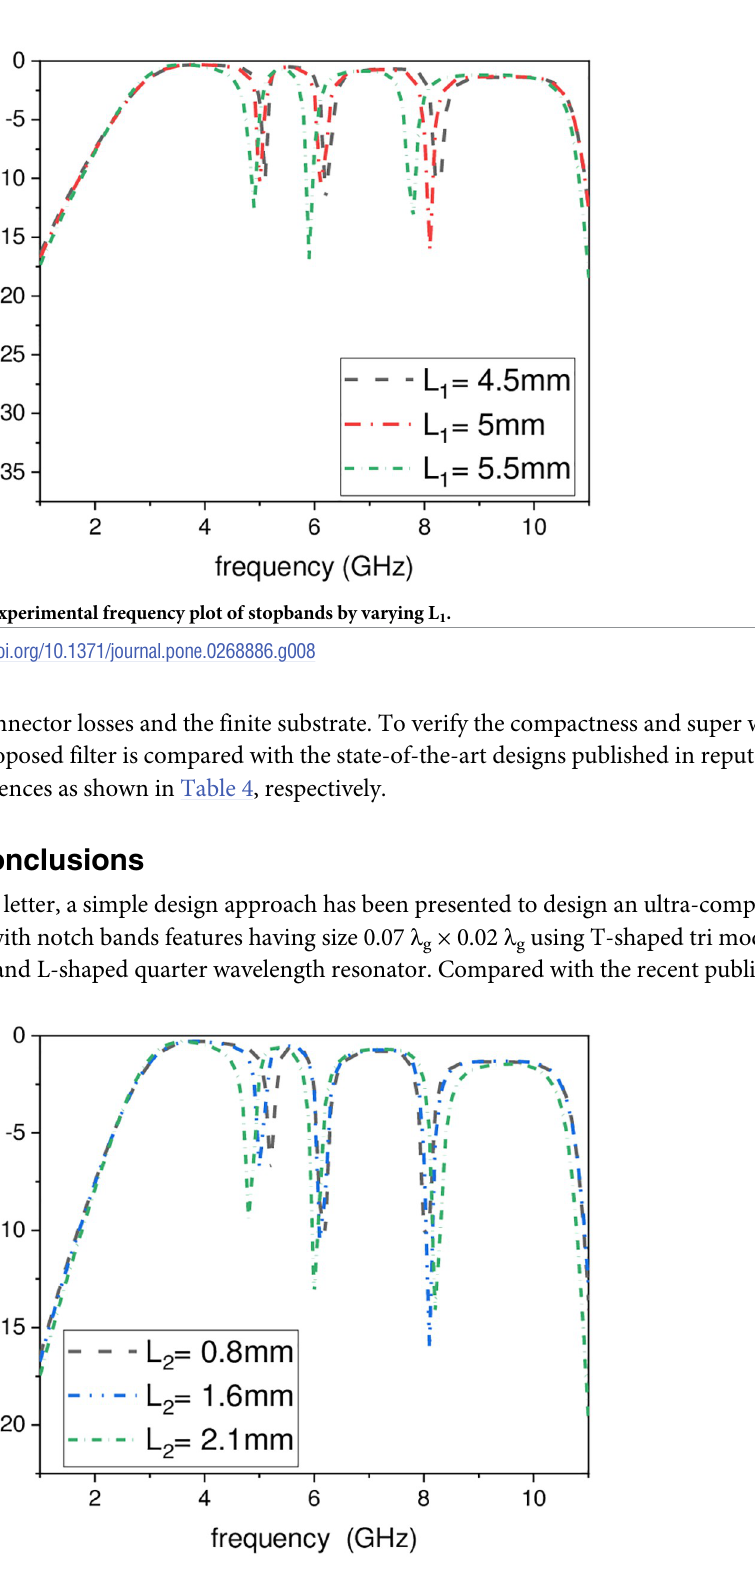
Fig 9. Experimental frequency plot of first NB control by varying L 2